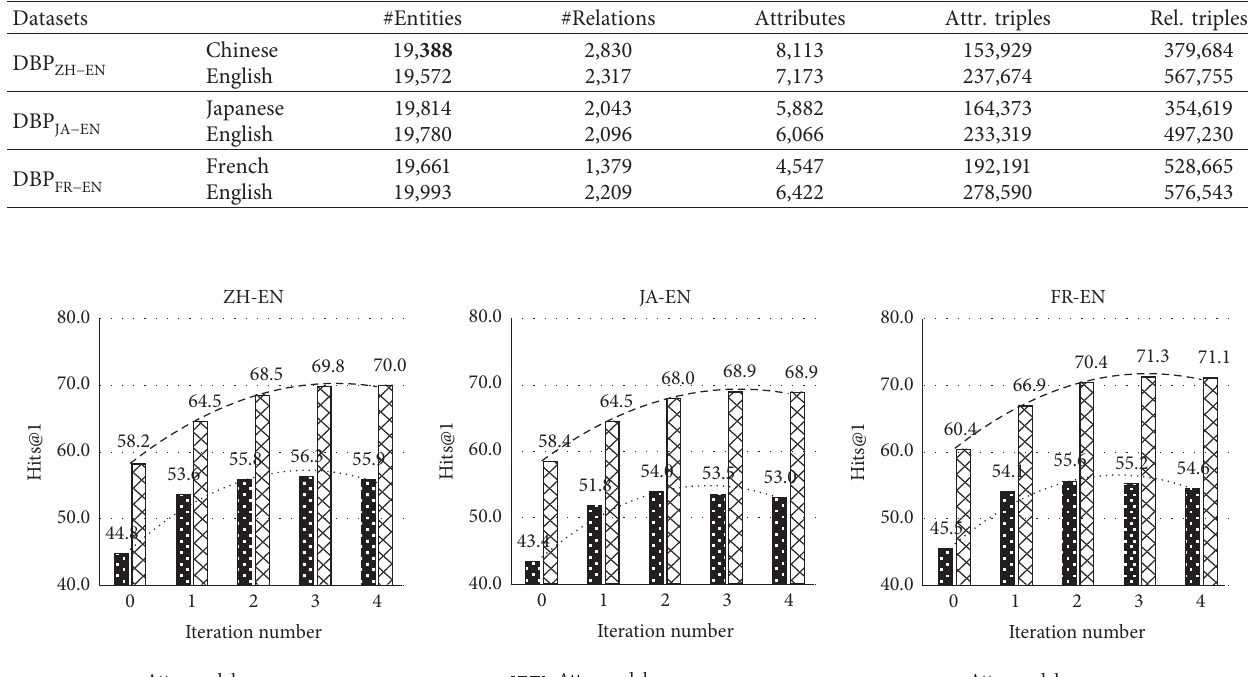
ZH-EN . (b) DBP JA-EN . (c) DBP FR-EN